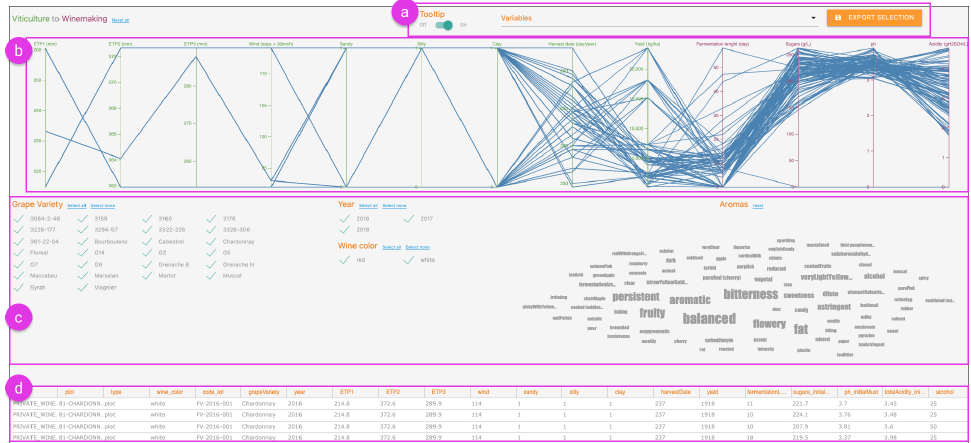
Figure 4. Interface for the exploratory analysis of heterogeneous data: ( a ) toolbar; ( b ) parallel coordinates (see Figure 5 for details); ( c ) filters (see Figure 6 for details); ( d ) data table (see Figure 7 for details).